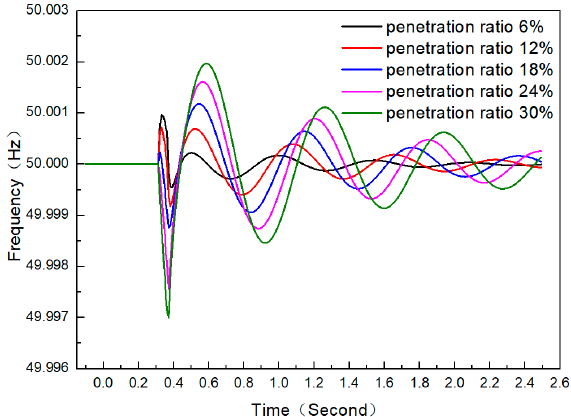
Figure 7. Effect of short-circuit events on node frequency after energy storage.